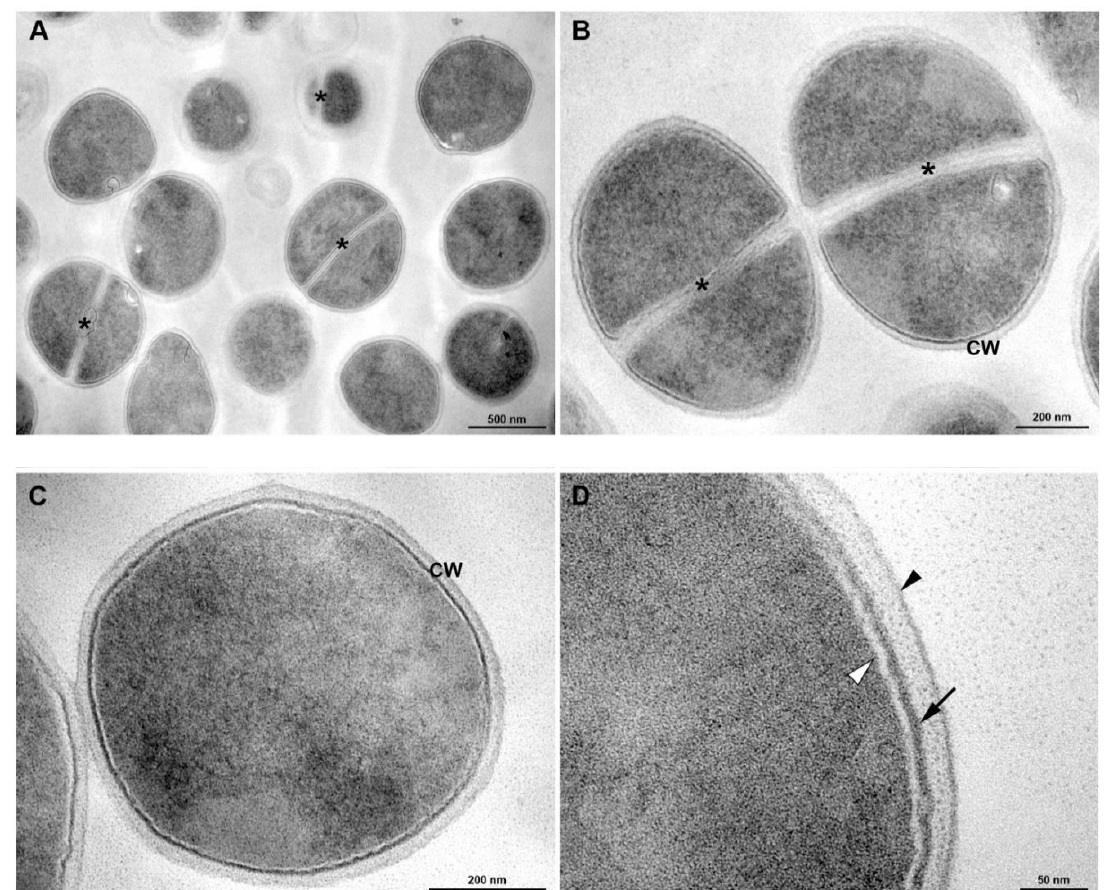
Figure 5. Transmission electron microscopy of S. aureus grown under culture medium. ( A ) General view showing rounded cells with a thick cell wall envelope and homogeneous electron density in the cytoplasm. Central division septa (*) are seen in some cells. ( B , C ) Detailed view of non-dividing ( B ) and dividing ( C ) bacteria A tripartite cell wall (CW) is seen enclosing the plasma membrane. Asterisk indicates the septum. ( D ) Inset of the cell wall. Black arrowhead indicates outer highly stained fibrous surface and intermediate translucent region; Arrow points to a heavily stained inner thin zone; the plasma membrane (white arrowhead) is seen immediately below this electrodense layer of the wall. Bars: A: 500 nm; B,C: 200 nm; D: 100 nm.